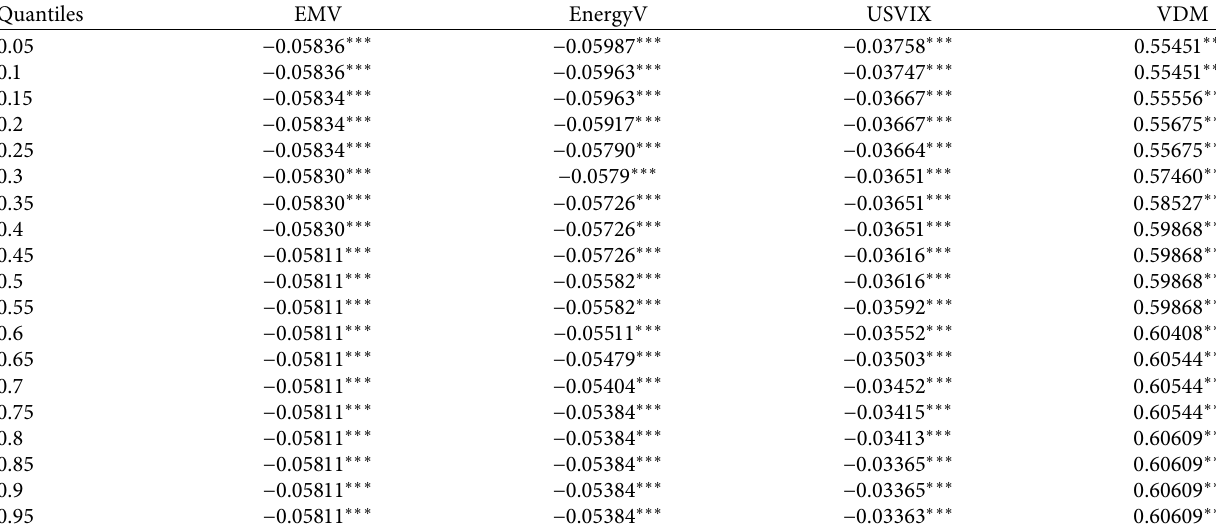
Table 6: Effect of volatilities on